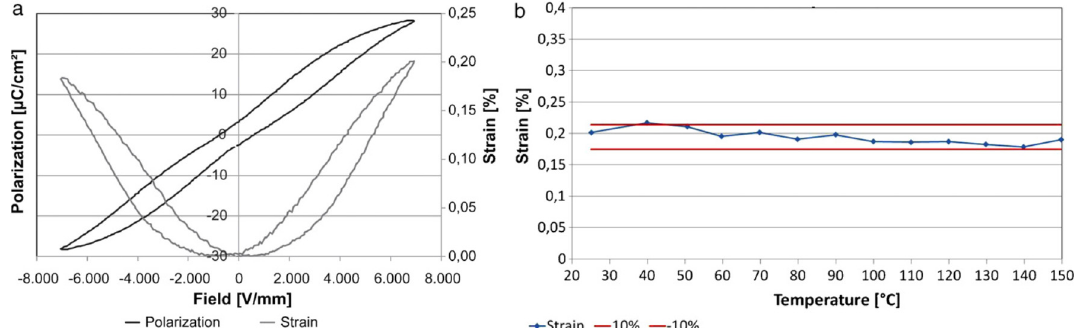
Figure 16. Polarization and displacement of a multilayer stack described by Krauss, et al. [141] at room temperature ( a ). Strain of the device at 7 kV/mm vs. temperature ( b ). Reprinted from [141] with copyright from Elsevier 2011.